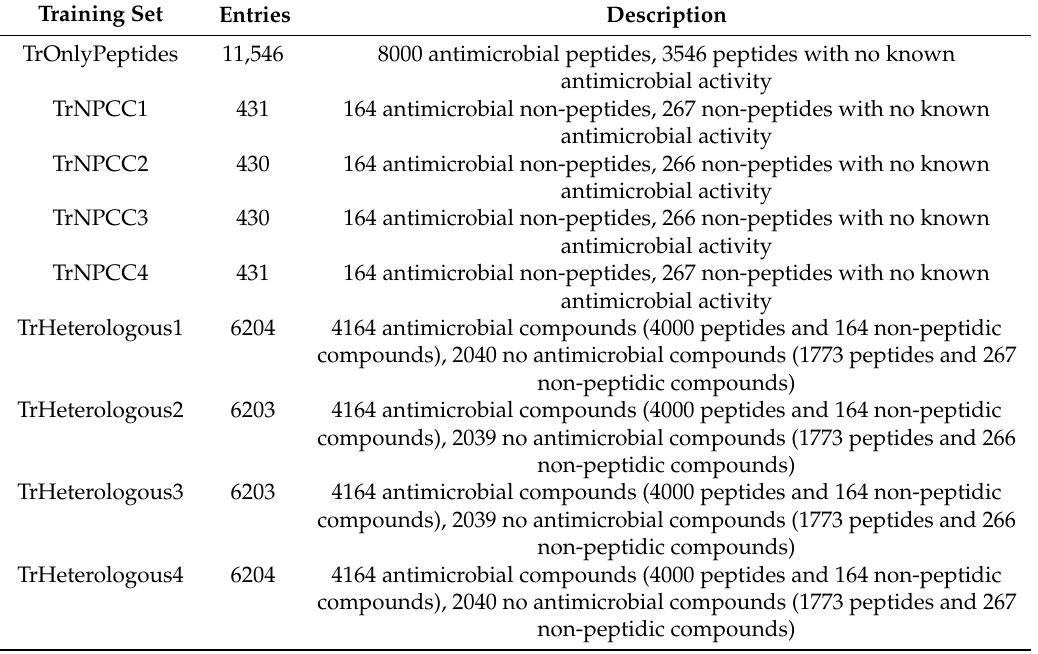
Table 1. Training data sets.